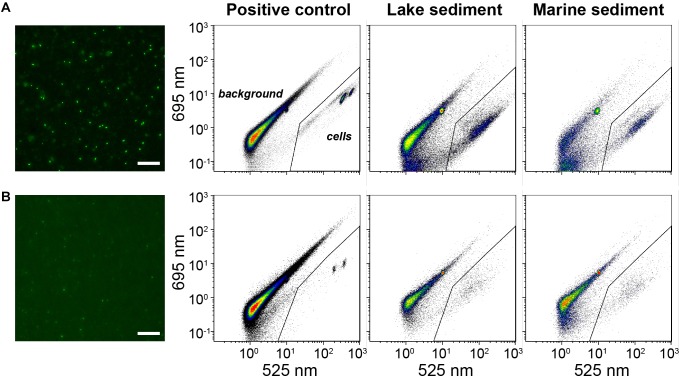
Comparisons of microscopic images and flow cytometric cytograms based on (A) membrane staining and (B) direct staining. Representative samples include positive control (autoclave-sterilized sediments spiked with E. coli cells), lake, and marine sediments. The gate (solid line) was set to discriminate the signals of stained cells from background signals. White bar: 25 μm.